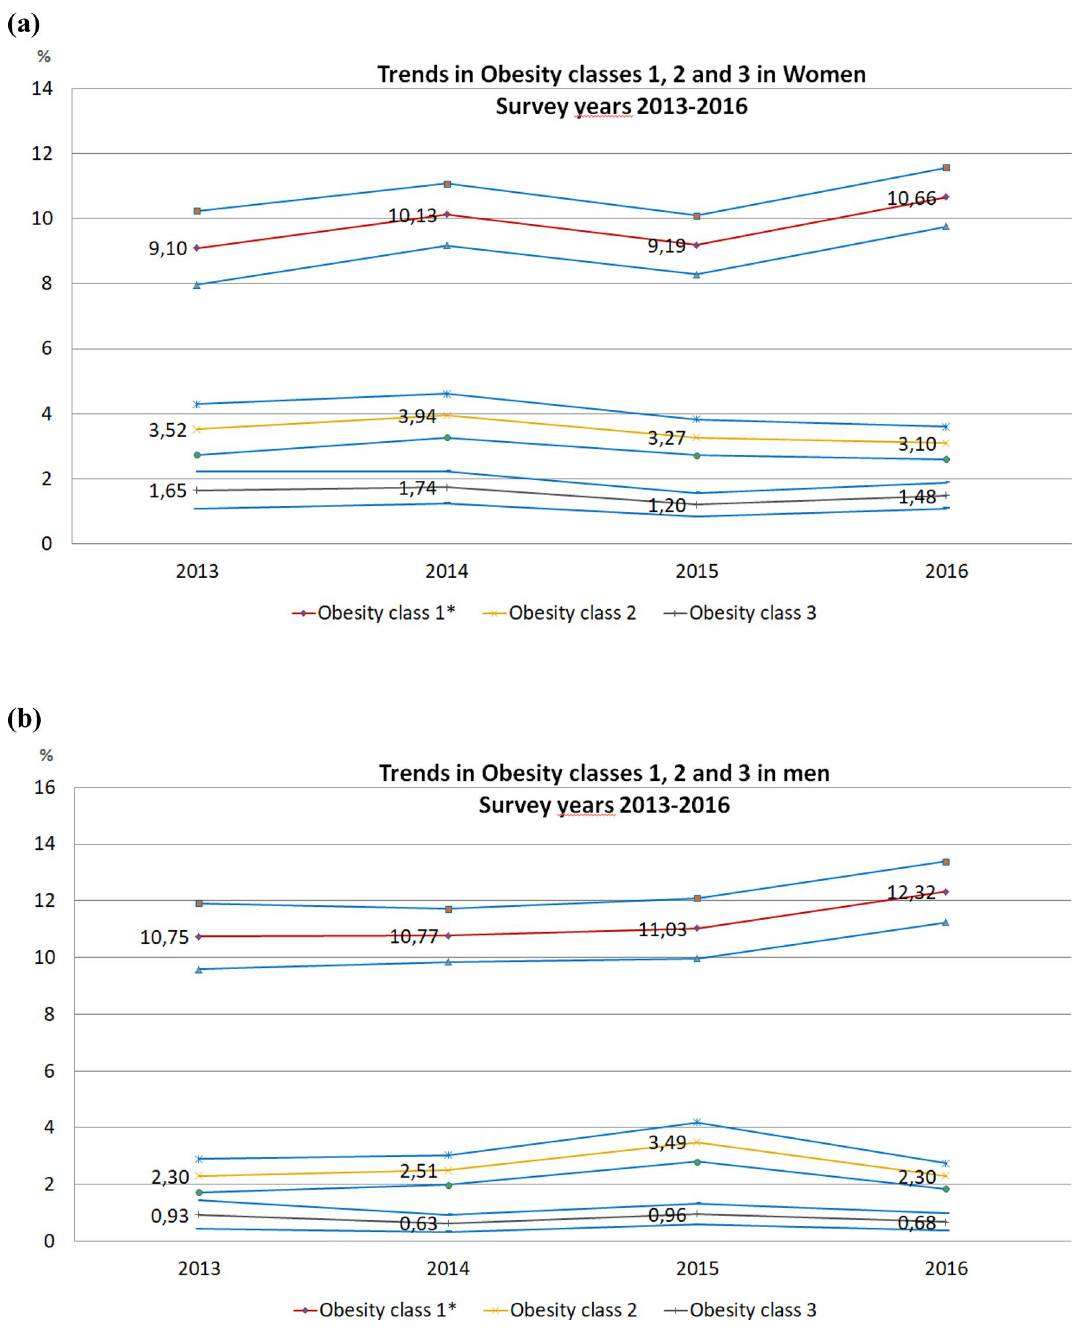
Figure 2. ( a ) Trends in obesity classes 1, 2 and 3 prevalence in women. Survey years 2013–2016. *Significant linear trend. P for trend estimated using the coefficients of orthogonal polynomials corresponding to linear contrast. P for linear trend for obesity grade 1 = 0.04 (F = 3.96), for obesity grade 2 = 0.27 (F = 1.20) and obesity grade 3 = 0.41 (F = 0.66). Age and sex-adjusted by the raking ratio method using the Insee data and age groups 18–29, 30–39, 40–49, 50–59, and 60–69 years. Dashed lines are confidence intervals. ( b ) Trends in obesity classes 1, 2 and 3 prevalence in men. Survey years 2013–2016. *Significant linear trend. P for trend estimated using the coefficients of orthogonal polynomials corresponding to linear contrast. P for linear trend for obesity grade 1 = 0.01 (F = 5.59), for obesity grade 2 = 0.32 (F = 0.97) and obesity grade 3 = 0.15 (F = 0.69). Age and sex-adjusted by the raking ratio method using the Insee data and age groups 18–29, 30–39, 40–49, 50–59, and 60–69 years. Dashed lines are confidence